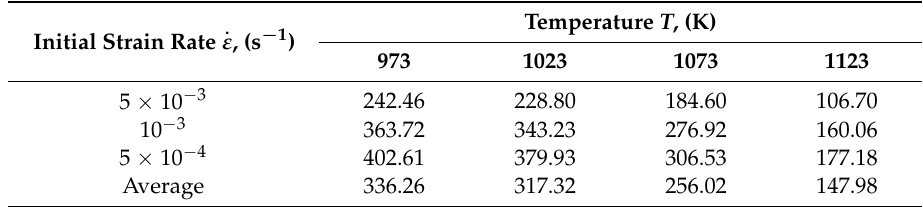
Table 2. Calculated activation energies as a function of deformation temperature and strain rate in Ti-6Al-4V